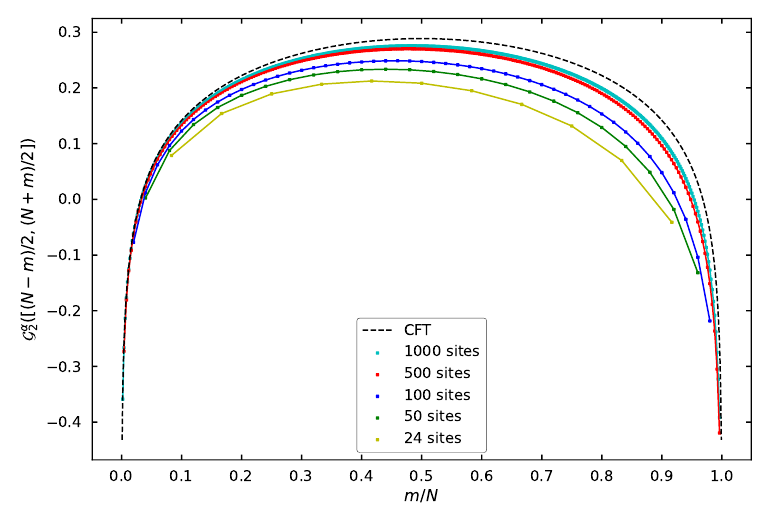
f ([( N − m ) / 2, ( N + m ) / 2 ]) for a wide range 2 G